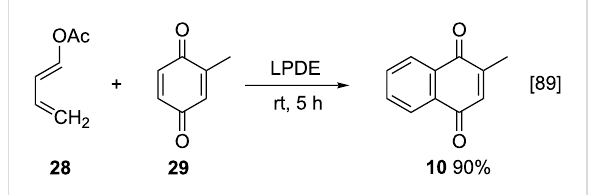
Scheme 5: Menadione synthesis via Diels–Alder